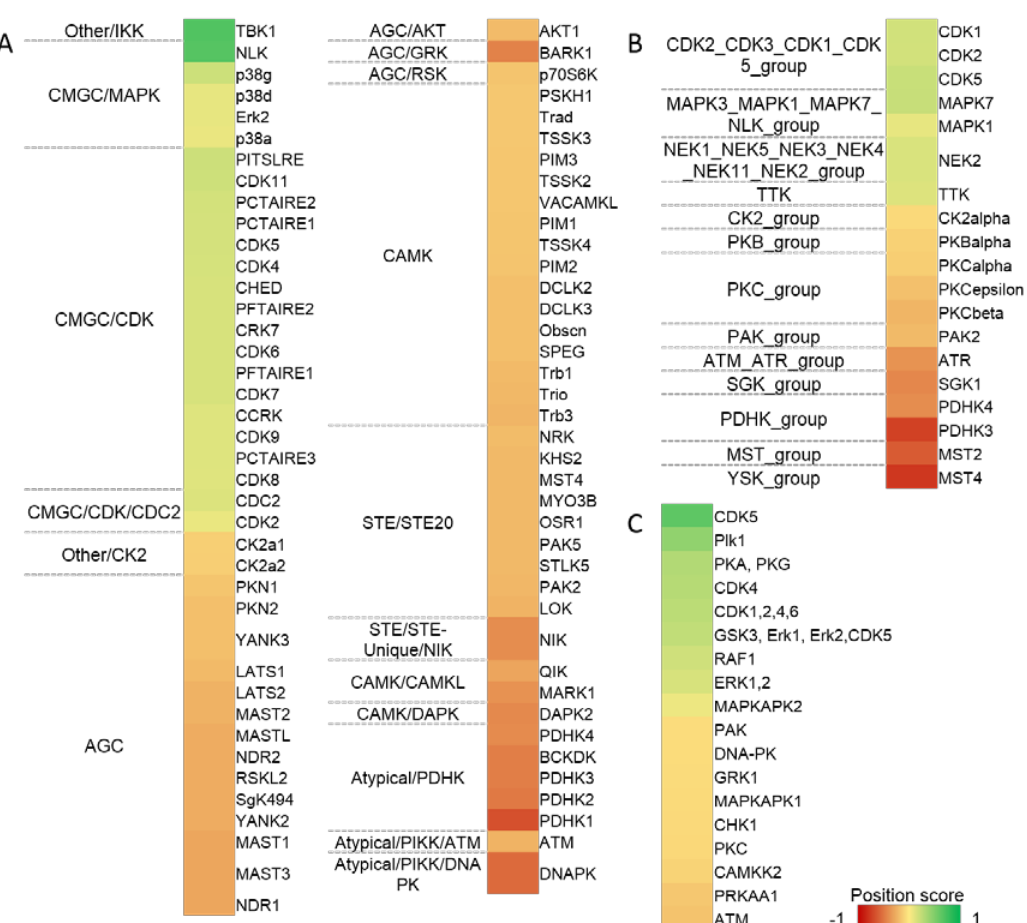
Figure 5. Analysis of kinases activity. Kinase-substrate relations predicted by iGPS ( A ) NetworKIN 3; and ( B ) linear motifs analysis derived from motifs stored in Human proteome reference database (HPRD) database; ( C ) The color shade corresponds to the value of the “position score” that indicates if the ratios (normalized H / L ratios) of sites phosphorylated by a particular kinase tend to be larger (0 to 1) or lower (−1 to 0) than the rest of the data ( p < 0.05), i.e. , green color of a region in a heatmap indicates an increased activity of a particular kinase after IR and VE-821 co-treatment, red color indicates trend of decreased